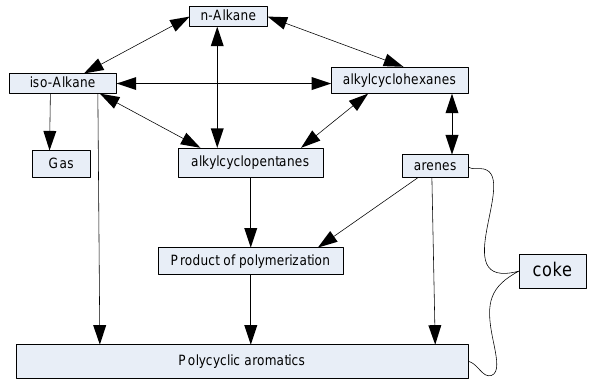
Figure 3: Conversion of hydrocarbons on zeolite catalysts [2]